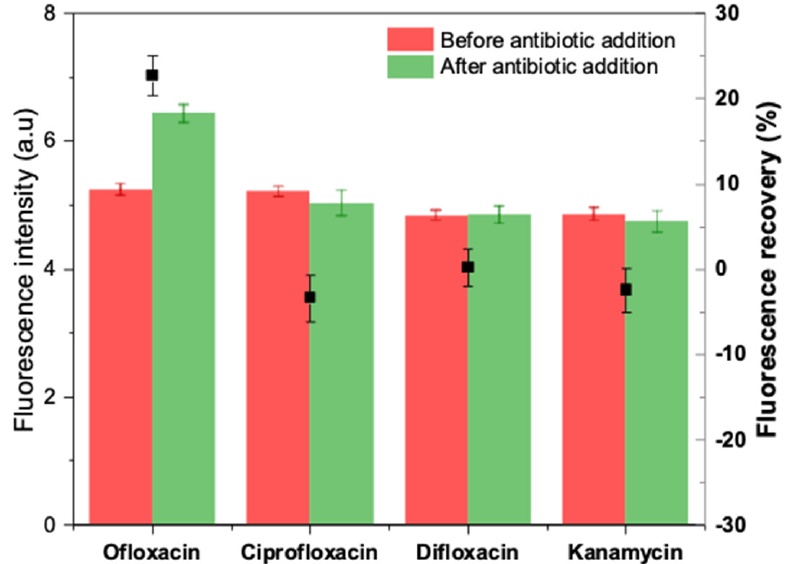
Figure 10. Selectivity of the apta-assay in the presence of other interfering antibiotics.